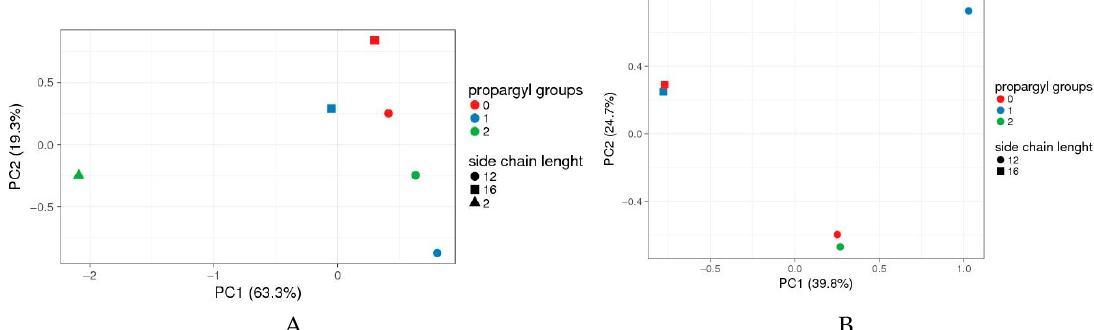
Figure 3. Principal Component Analyses (PCA) data of 4-( N -alkylpyridinium)-1,4-DHP toxicity when analysed by compound boundary concentrations. ( A ) Full set of compounds, ( B ) 1,4-DHP 7 omitted. Boundary concentrations from all tested 1,4-DHP derivatives tested in all microorganisms were collected in a score matrix (Table S1 in Supplementary Material); the results formed a four-dimension matrix (number of propargyl groups; side chain length; microorganism; boundary concentration). To find out which of the parameters (number of propargyl groups and/or side chain length) has the most significant impact on the compound’s toxicity, the “artificial” set of variables that would help to visualise the main effects of data variance across a two-dimensional (2D) plot was sought. The data were analysed and visualised by online tool ClustVis [33]. Vector scaling is applied to rows; the Nonlinear Iterative Partial Least Squares (NIPALS) algorithm is used to calculate principal components [42]. The scores of individual compound’s toxicities are plotted using the first two principal components, which explain most of the variance (PC1 63.3% and PC2 19.3% for A, and 39.8% and 24.7% for B). Green triangle: 4-( N -ethylpyridinium)-1,4-DHP 7